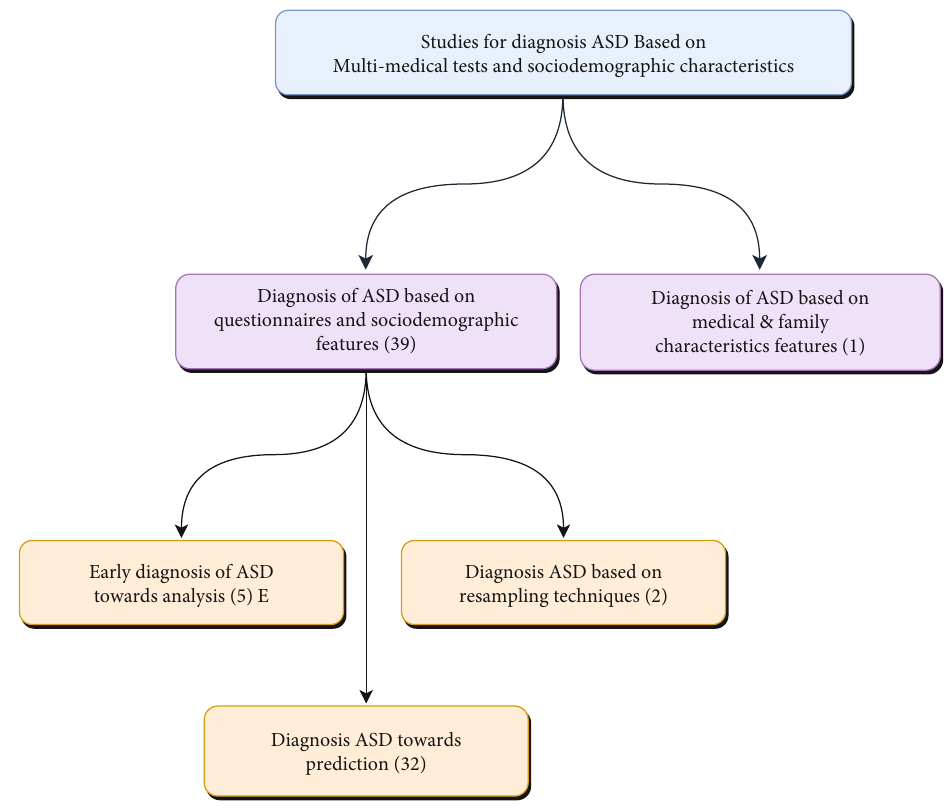
Figure 7: Taxonomy of research literature on diagnosis of